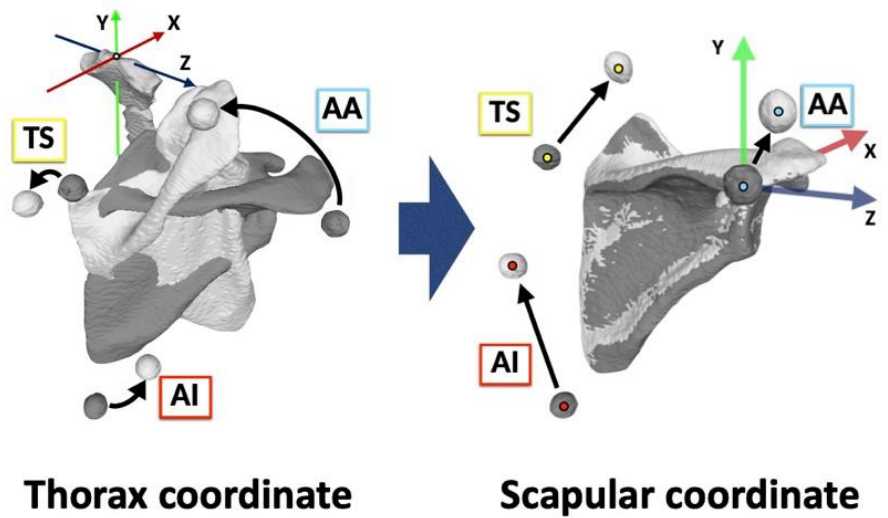
Figure 6. Visualization of the scapular skin marker movements. Black arrows show the marker movements from the reference position (gray) to the elevated position (white). The 3D movements of the scapula and markers were visualized on the thorax coordinate system. The 3D scapular marker displacement was identified aligned to the scapular coordinate system. AA, acromial angle (angulus acromialis); TS, root of the scapular spine (trigonum spinae scapulae); AI, inferior angle (angulus inferior). The total marker movement distances of AA, TS, and AI from the reference position to the elevated position were obtained using the center translation distances of these markers by calculating Euclidean